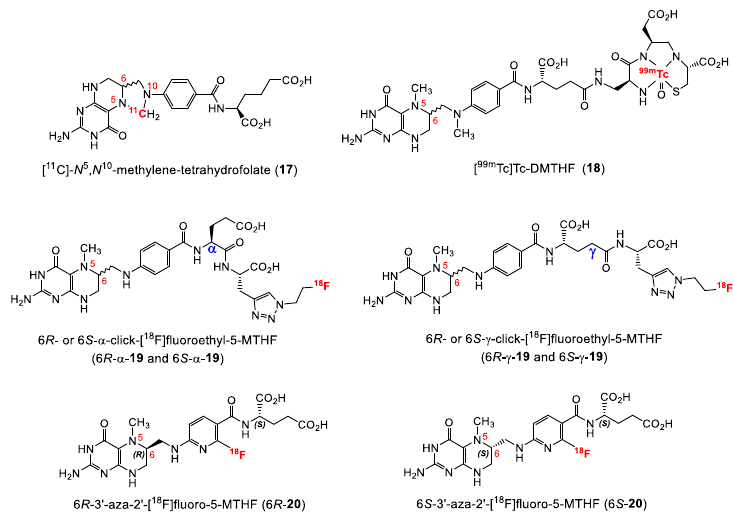
Figure 6. Structures of radiolabeled reduced folate radiotracers.